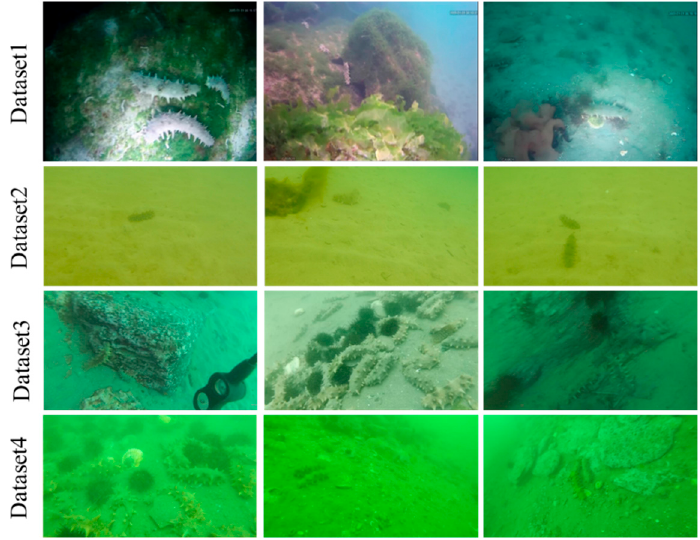
Figure 2. Sea cucumber images in each